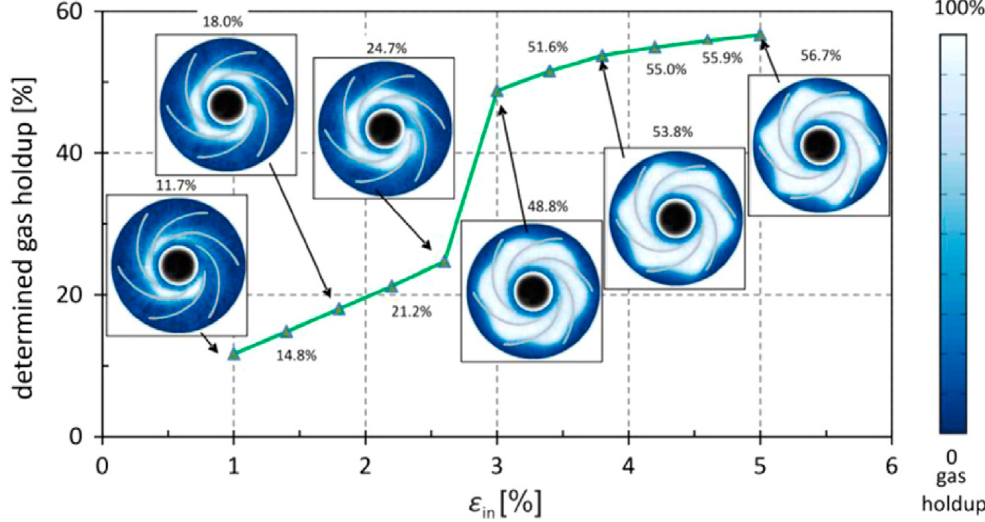
Figure 12. In-situ gas void fractions at various intake GVFs measured by HireCT [68].